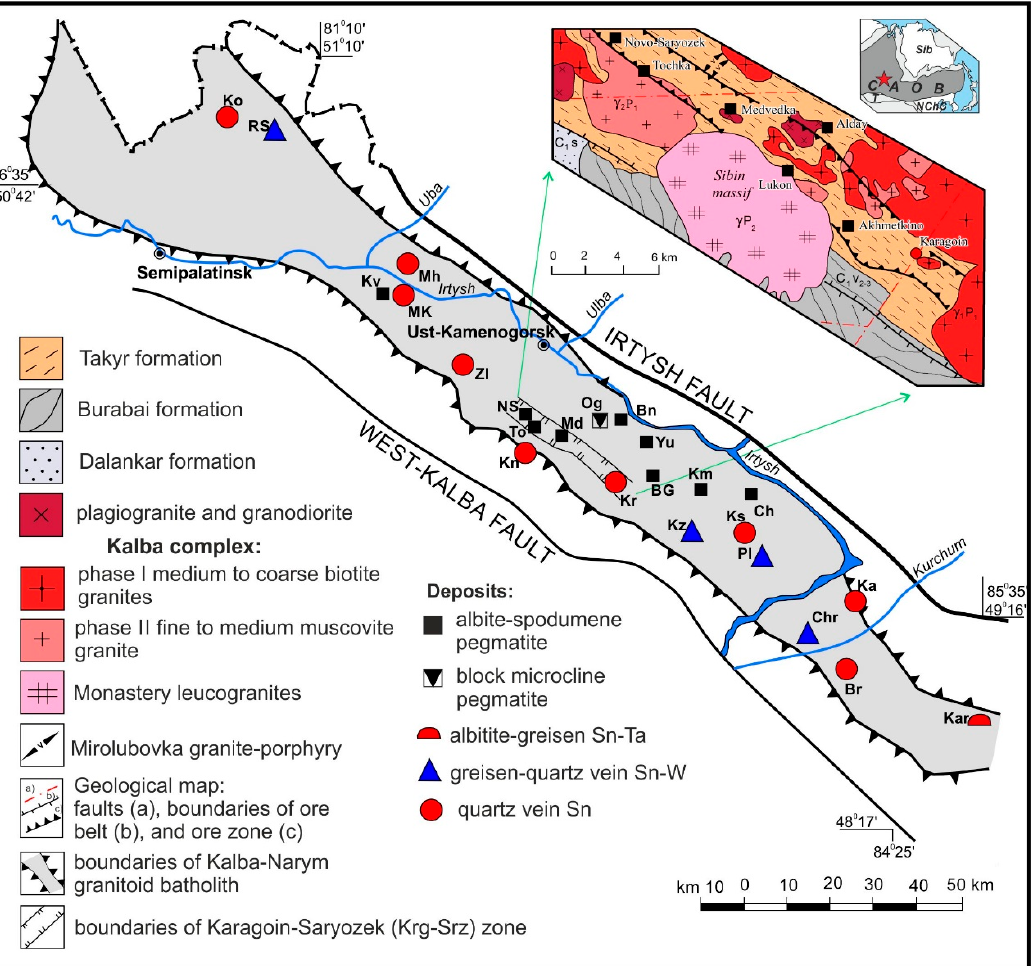
Figure 1. Location map of rare-metal deposits and occurrences in the Kalba–Narym belt [30]. Abbreviations stand for names of mineral deposits: Ko—Korosteli; RS—Rzhavaya Sopka; Mh—Mokh-